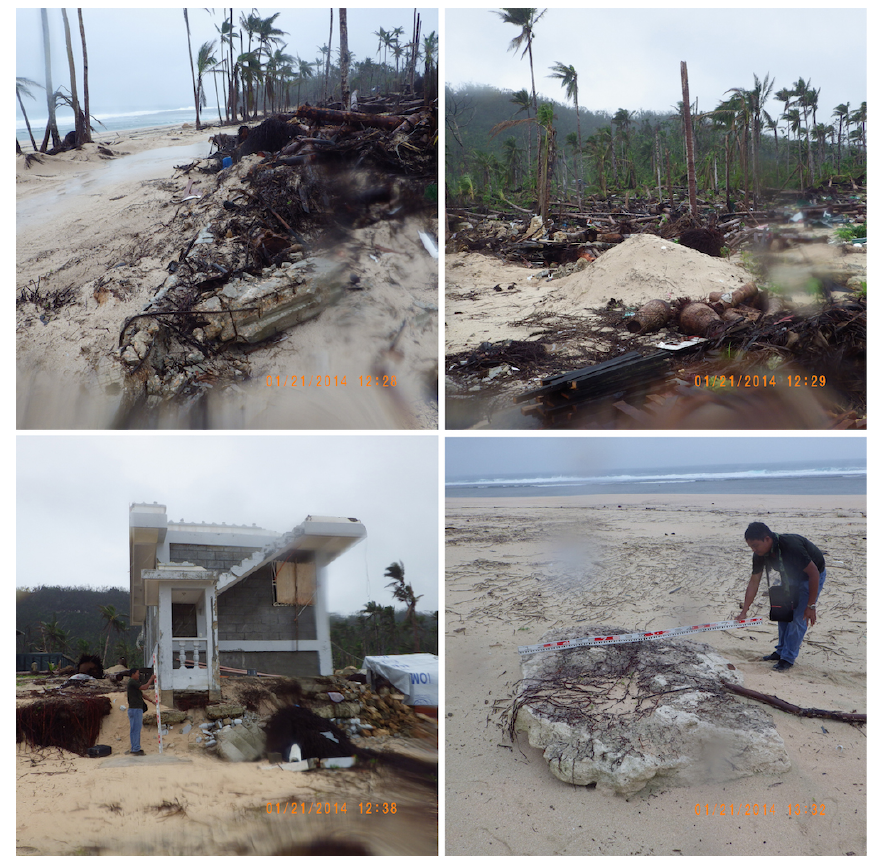
Figure 14. Jagnaya Beach area, east of Salcedo village. Extensive sand erosion and deposition to inland was observed. In addition, coral boulders were observed on the beach, which were possibly carried inland by the